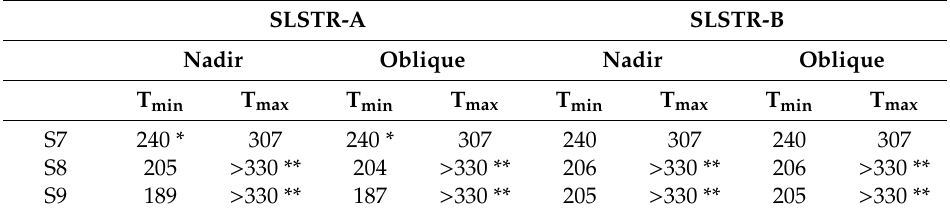
Table 5. Minimum and maximum scene temperatures for SLSTR-A and B. SLSTR-A SLSTR-B Nadir Oblique Nadir Oblique T min T max T min T max T min T max T min T max S7 240 * 307 240 * 307 240 307 240 307 S8 205 > 330 ** 204 > 330 ** 206 > 330 ** 206 > 330 ** S9 189 > 330 ** 187 > 330 ** 205 > 330 ** 205 > 330